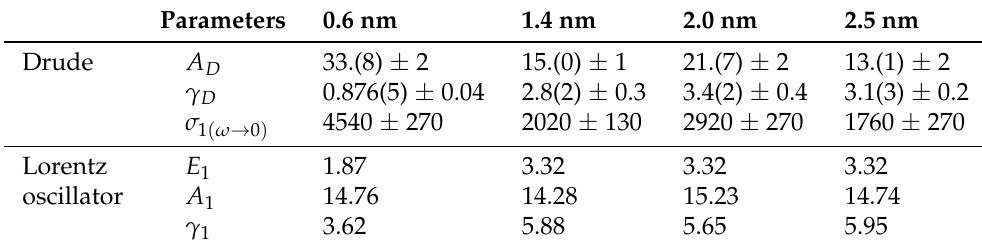
Table 2. Drude–Lorentz parameters for the 1.8nm thick NiFe layer in the [Bi(0.6,1.4,2.0,2.5nm)– NiFe] 16 -multilayered films obtained from the simulations of the model dielectric function described by Equation (1). The values of E 1 , γ 1 , and γ D are given in eV and optical conductivity limit σ 1 ( ω → 0 ) in Ω − 1 · cm − 1